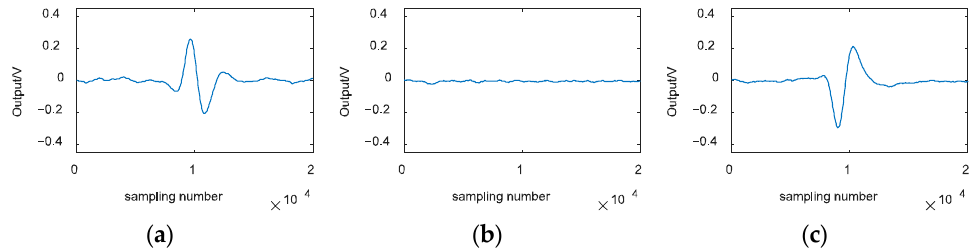
Figure 13. Experimental testing signal of B n for transverse cracks at different paths: ( a ) path A; ( b ) path B; ( c ) path C.